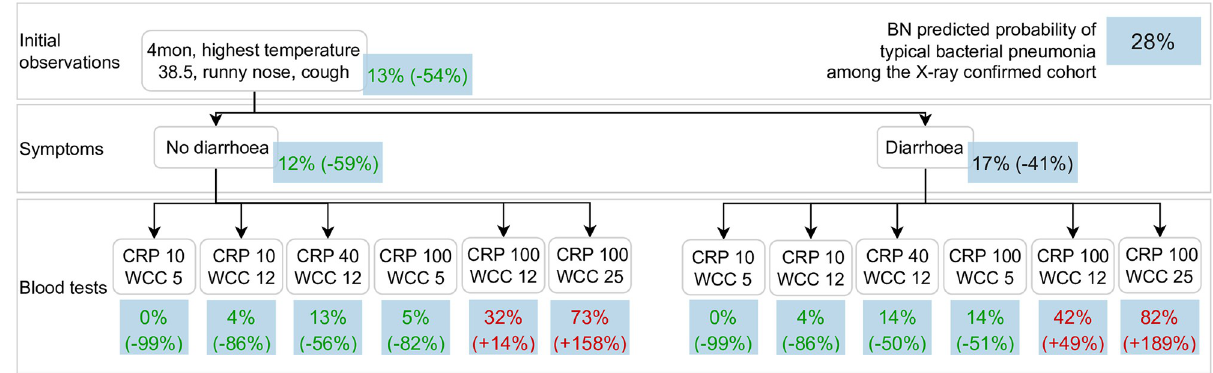
Fig 9. Clinical scenario 1, BN v4.5. This use case presents an infant ( age group (1) ) with X-ray confirmed pneumonia, moderately high temperature ( highest temperature (37) ), cough (29) and runny nose ( rhinorrhoea (31) ). The BN predicts a low probability of typical bacterial pneumonia for this child ( causative pathogen for pneumonia (25) ), and a reported history of diarrhoea (40) alone does not largely affect the prediction. The target prediction remains low unless both the C-reactive proteins (55) and white cells count (56) are moderately elevated.